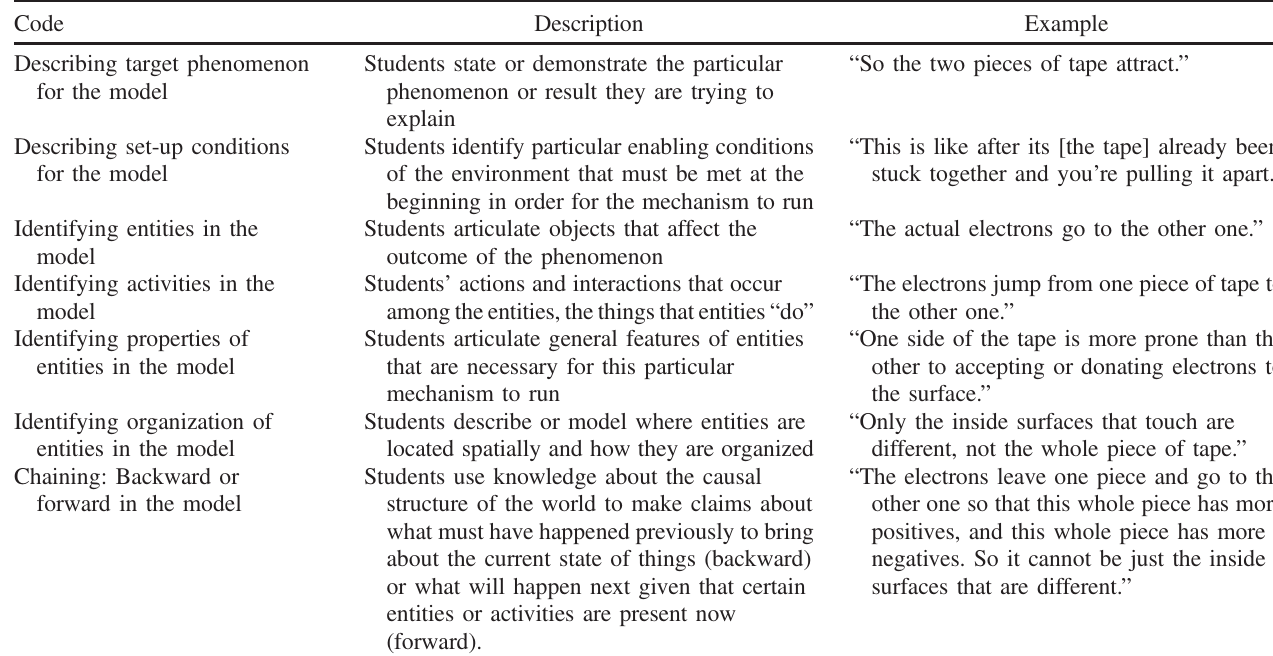
TABLE I. Mechanism coding